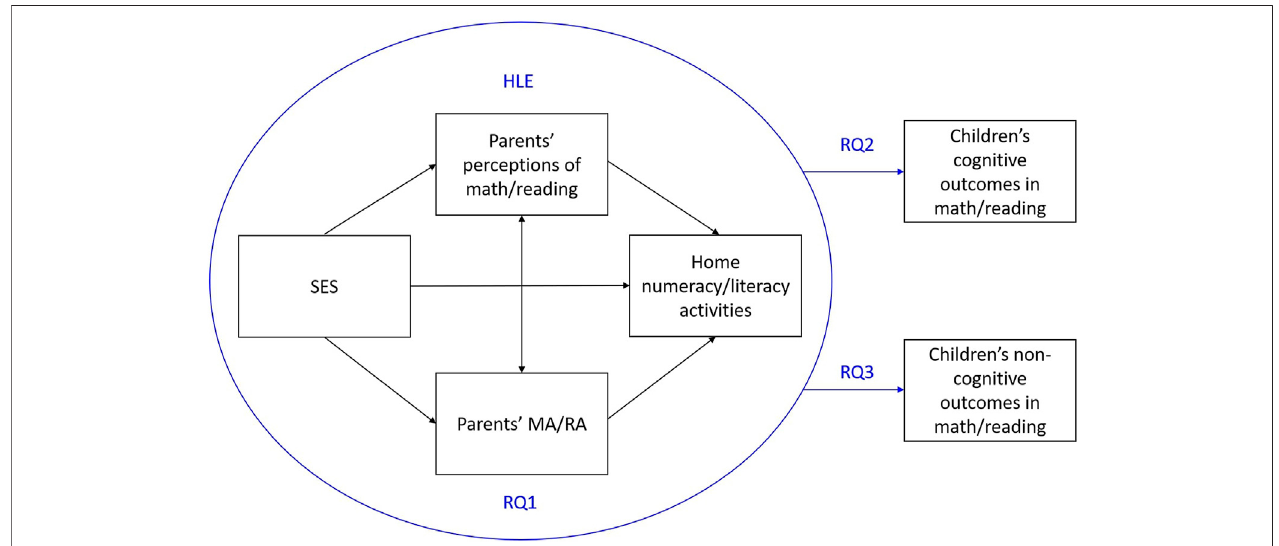
FIGURE1| AconceptualmodelsummarisingtherelationswithintheHLEandtherelationsbetweentheHLEandchildren ’ soutcomeswhichtobeexaminedinthis